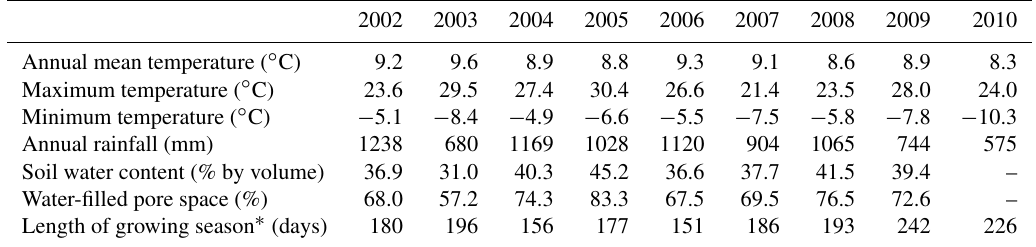
Table 2. Weather characteristics of each measurement year.